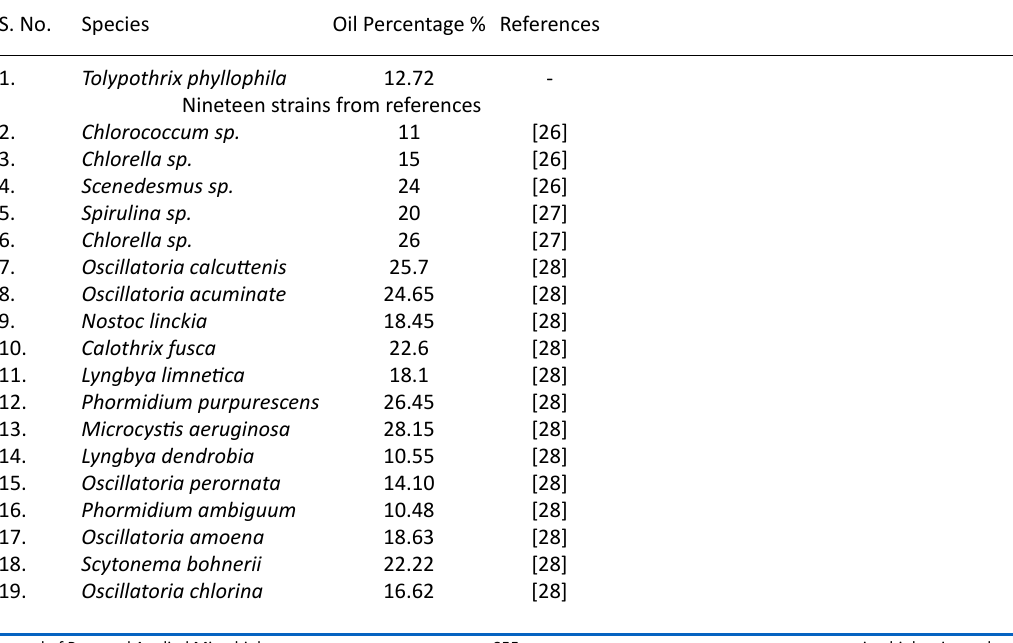
Table 1. Oil percentage in Tolypothrix phyllophila from this study and other eighteen algal and blue-green algal strains from literature S.